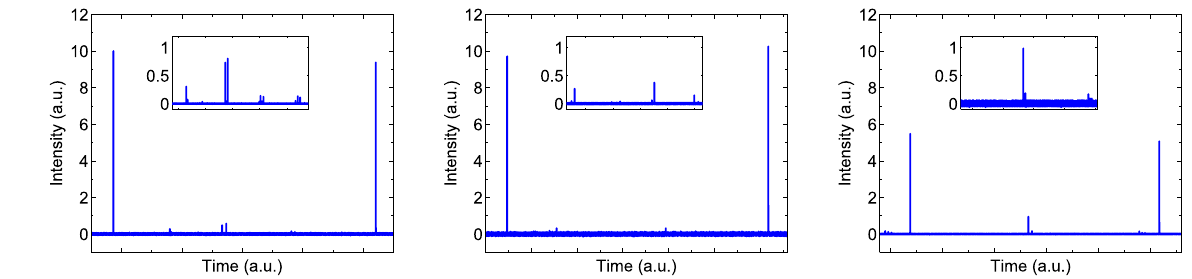
Figure 2. Transmission spectra at three different mean cavity lengths, L c = ( a ) 132 μ m, ( b ) 426 μ m, ( c ) 536 μ m while the cavity is scanned by the piezo actuator over approximately one FSR. The inset spectra magnify the middle parts of the scans to show higher order modes.